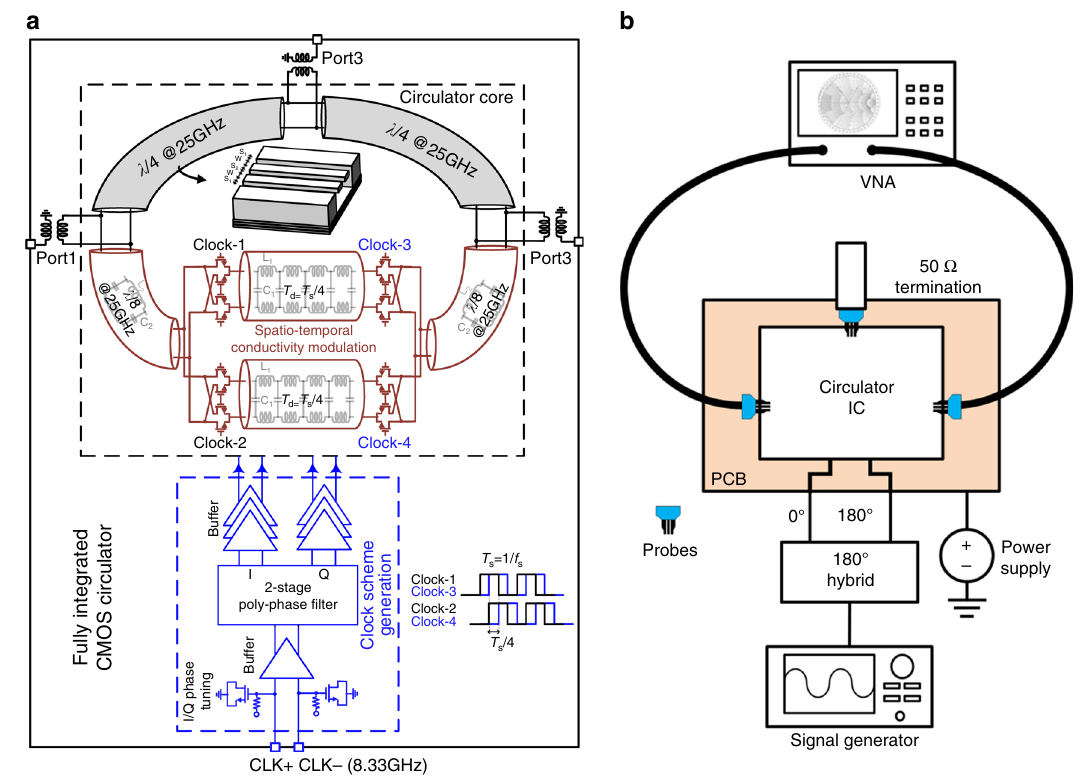
Fig. 6 Implementation and measurement of the millimeter-wave CMOS circulator. a Block and circuit diagram of the circulator. Non-reciprocal phase response is realized through spatiotemporal conductivity modulation (at 1/3rd of operation frequency) across balanced in-phase and quadrature transmission lines using passive transistor-based in-phase and quadrature switches without direct-current bias. A 3 λ /4 transmission line loop is wrapped around the non-reciprocal phase element to realize the circulator. The control signals for the spatiotemporal conductivity modulation are generated using on-chip clock generation circuitry. b Setup for the measurement of S-parameters. The chip is mounted on a printed circuit board and is probed two ports at a time. The third port is terminated with a third millimeter-wave probe that is terminated with a broadband 50 Ω